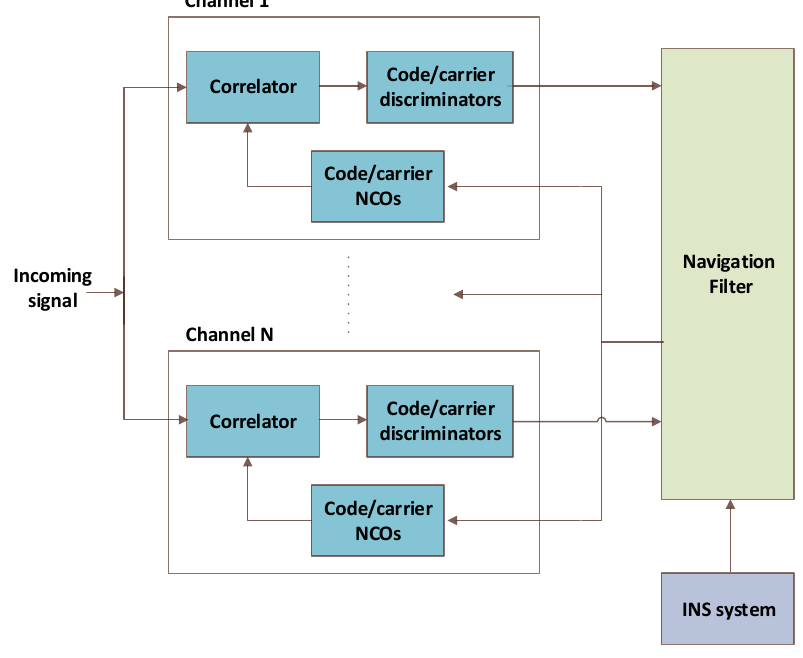
Figure 3. Ultra-Tightly-Coupled GPS/INS Integration.